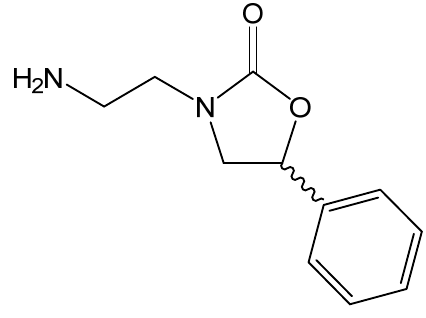
Figure 4. Structure of NH 2OX .